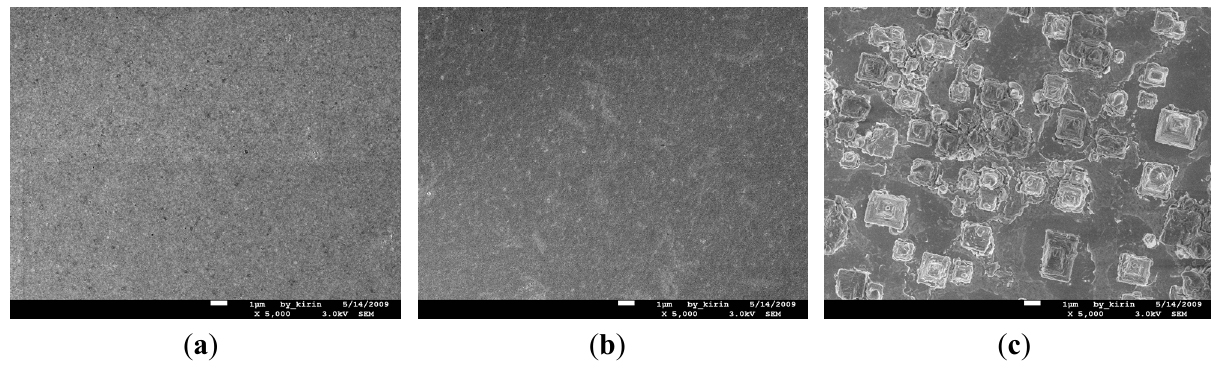
Figure 16. SEM images for the surface morphologies of structures of MgO (0.5 nm) sample annealed for 5 min at temperature 500 °C ( a ); 550 °C ( b ); and 600 °C ( c ), respectively.